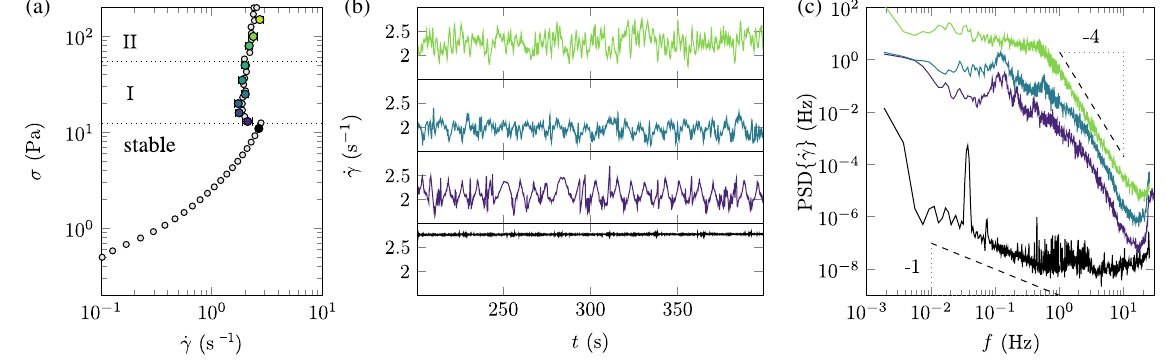
FIG. 2. Mechanical response to shear stress of a dense cornstarch suspension at 41 wt %. (a) Flow curve recorded in a small-gap concentric-cylinder geometry by ramping up the imposed stress σ with 40 s per point (gray circles) and through subsequent long experiments of at least 2500 s each under constant stresses (colored circles; the shear rate _ γ is averaged over 2500 s and error bars correspond to the standard deviation). The dashed lines indicate the limits of the various DST regimes discussed in the text. (b) Snapshots of long-time series of _ γ ð t Þ for four imposed stresses: σ ¼ 11 (black), 13 (purple), 25 (blue). and 100 Pa (green) from bottom to top. (c) Power spectral density of _ γ ð t Þ for the four imposed stresses shown in (b) with the same colors. For clarity, the PSDs at 25 and 100 Pa were shifted vertically by a factor of 10 and 100, respectively.